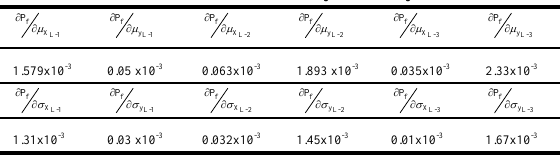
Fig. 2. Flow-chart of the modeling of multistage machining process.